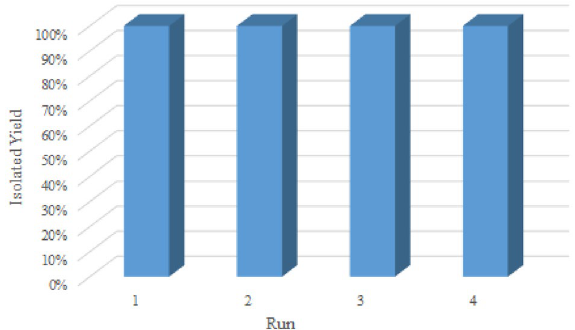
Figure 10. Recyclability of Mo–MOF in the esterification of oleic acid with